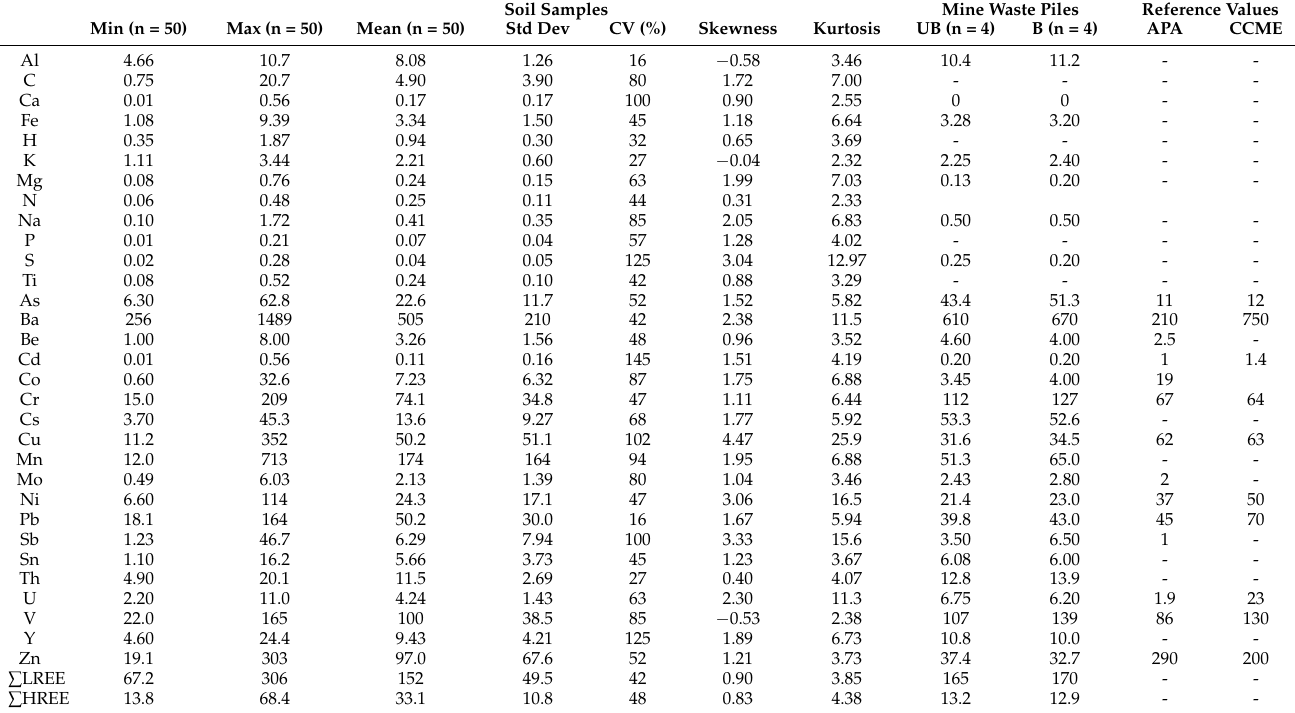
Table 2. Descriptive statistics of general soil inorganic geochemistry of major (%) and trace elements (mg/kg) and comparison with previous waste pile analytical results [14] and with national and international reference values